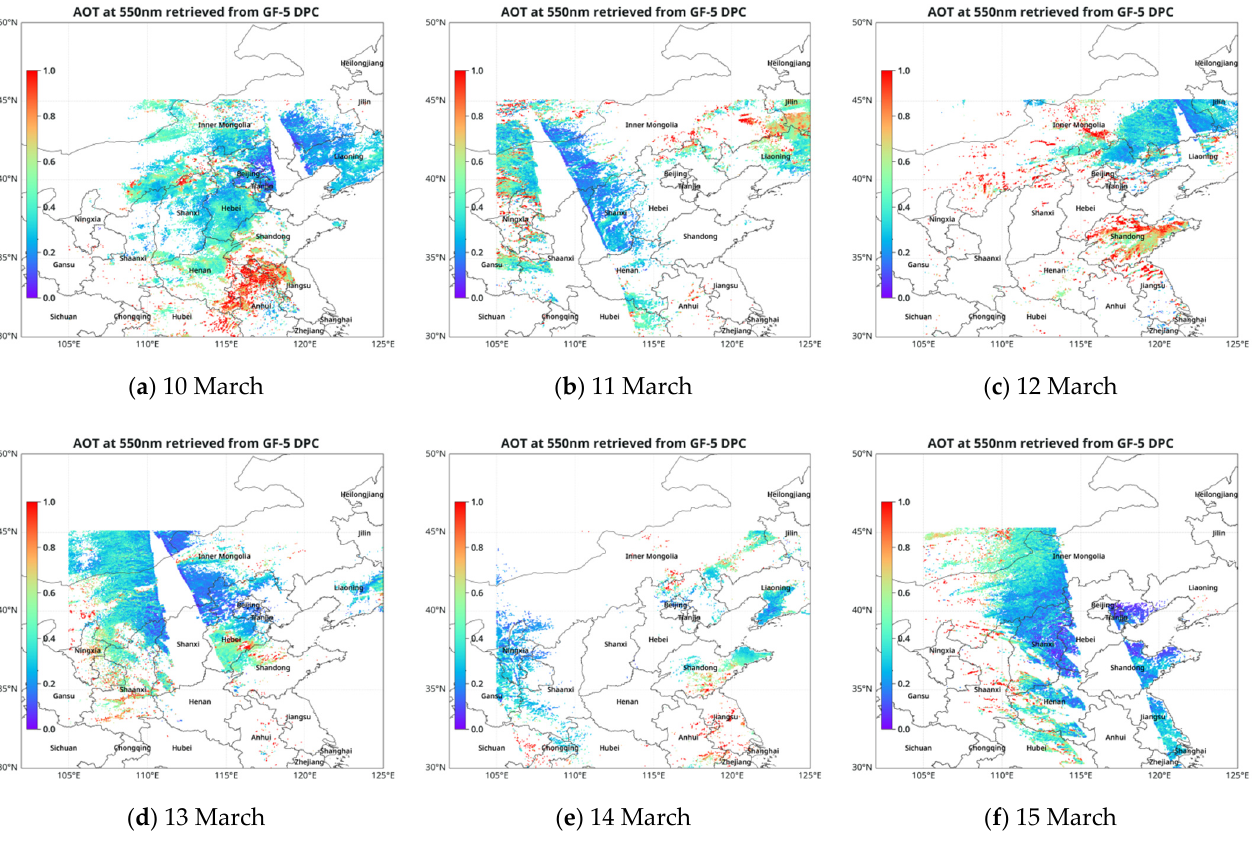
Figure 10. The retrieved AOD with DPC over northern China from ( a – f ) 10 March to 15 March